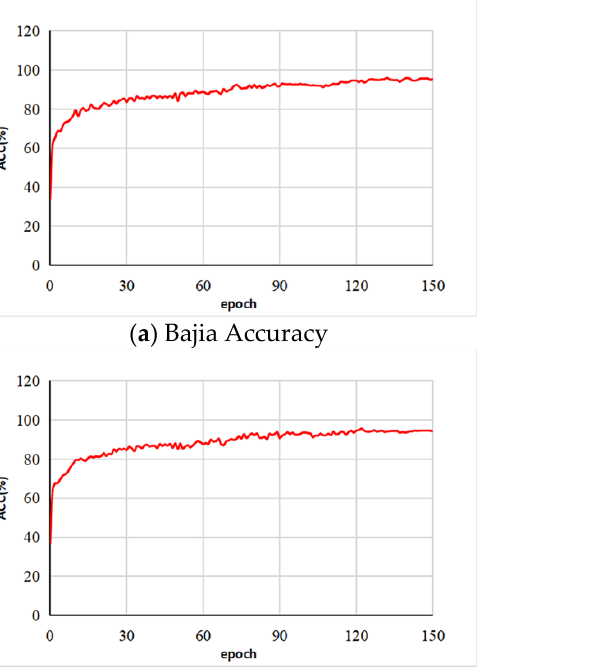
Figure 9. ( a – f ) Results of the energy and semantic segmentation of two different datasets, in the semantic segmentation results. The left graph shows the manually calibrated reference and the right shows the predicted results.